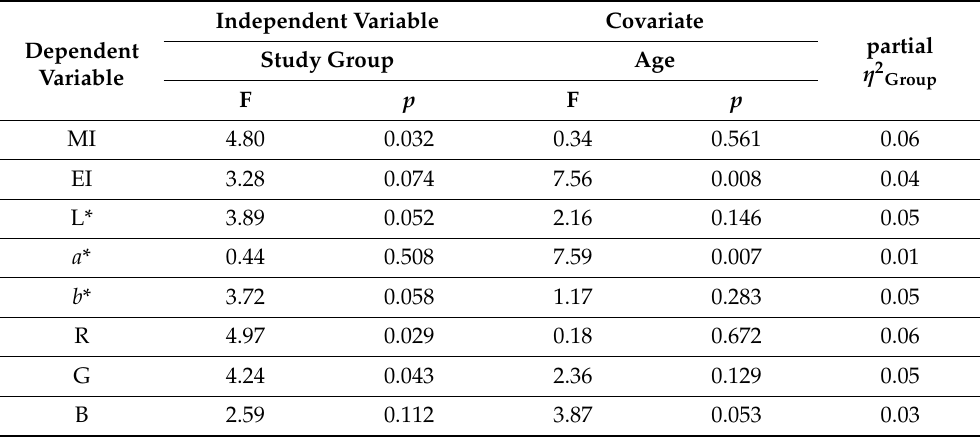
Table 4. ANCOVA results showing differentiation of the spectrophotometric skin color parameters depending on the study group in men (adjusted for